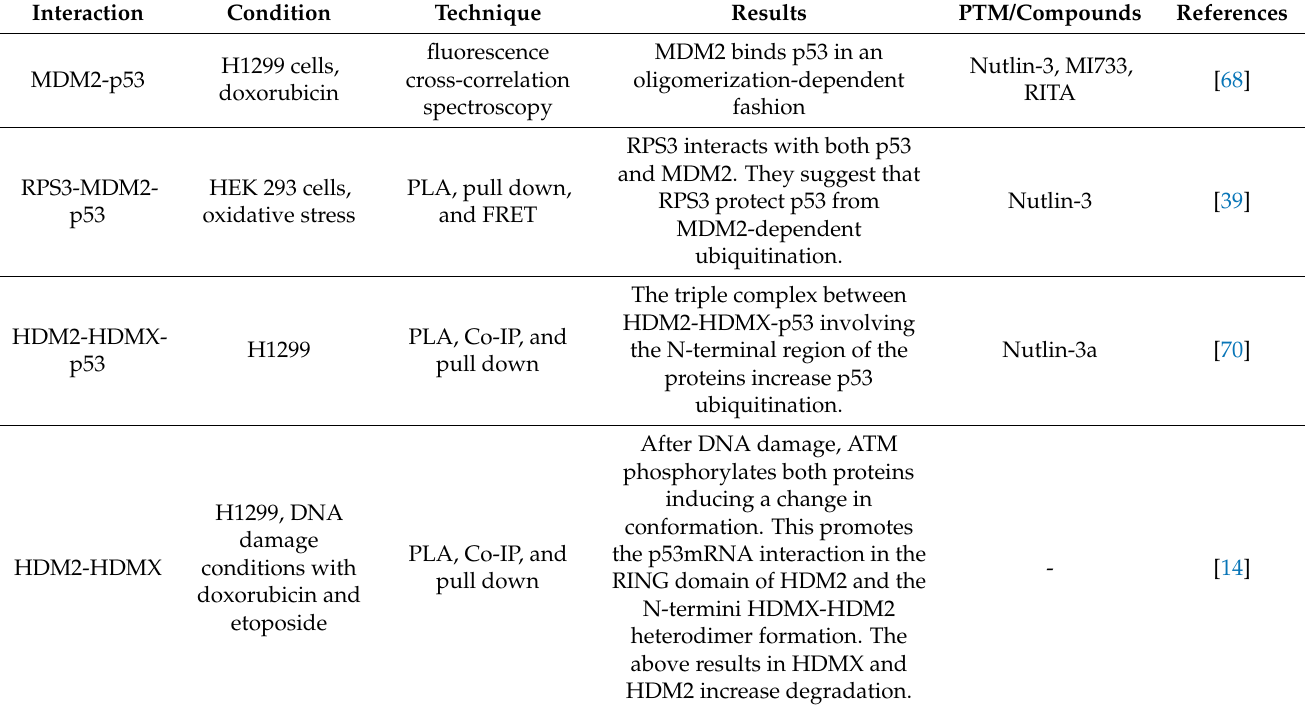
Figure 1. Illustrations of novel techniques used to detect interactions in the p53 pathway. ( a ) Fluorescence cross-correlation spectroscopy (FCS) used to study the p53-MDM2 interaction in living cells. FCS uses proteins that are labelled independently with different fluorescent probes. Analysis of the FCS data examines minute fluctuations in fluorescence intensity induced by a low number of diffusing labelled molecules, caused by spontaneous deviations from the mean in thermal equilibrium in a confocal configuration [68]. ( b ) Proximity ligation assay (PLA), used to study the interaction of the p53 mRNA in the RING domain of HDM2 and the formation of the N-terminal HDMX-HDM2 heterodimer. This technique consists of two primary antibodies generated in different species that recognize the proteins of interest and two secondary antibodies that carry oligonucleotide sequences that are ligated and amplified, allowing detection by fluorophores [14]. ( c ) Proximity ligation ELISA (PLE) set to investigate the trimeric interaction among MDM2 and the nascent p53 peptide on isolated p53 polysomes (via RPL5 or RPL11). PLE involves three primary antibodies. One capture antibody (i.e., from goat), targeting one binding factor and a set of primary antibodies (from mouse and rabbit), targeting two additional binding factors. Upon capturing the trimeric complex via the capture antibody, recognizing one of the binding partners, signal amplification, and detection is performed following the principles of PLA. Table 3. p53 pathway interactions detected with new